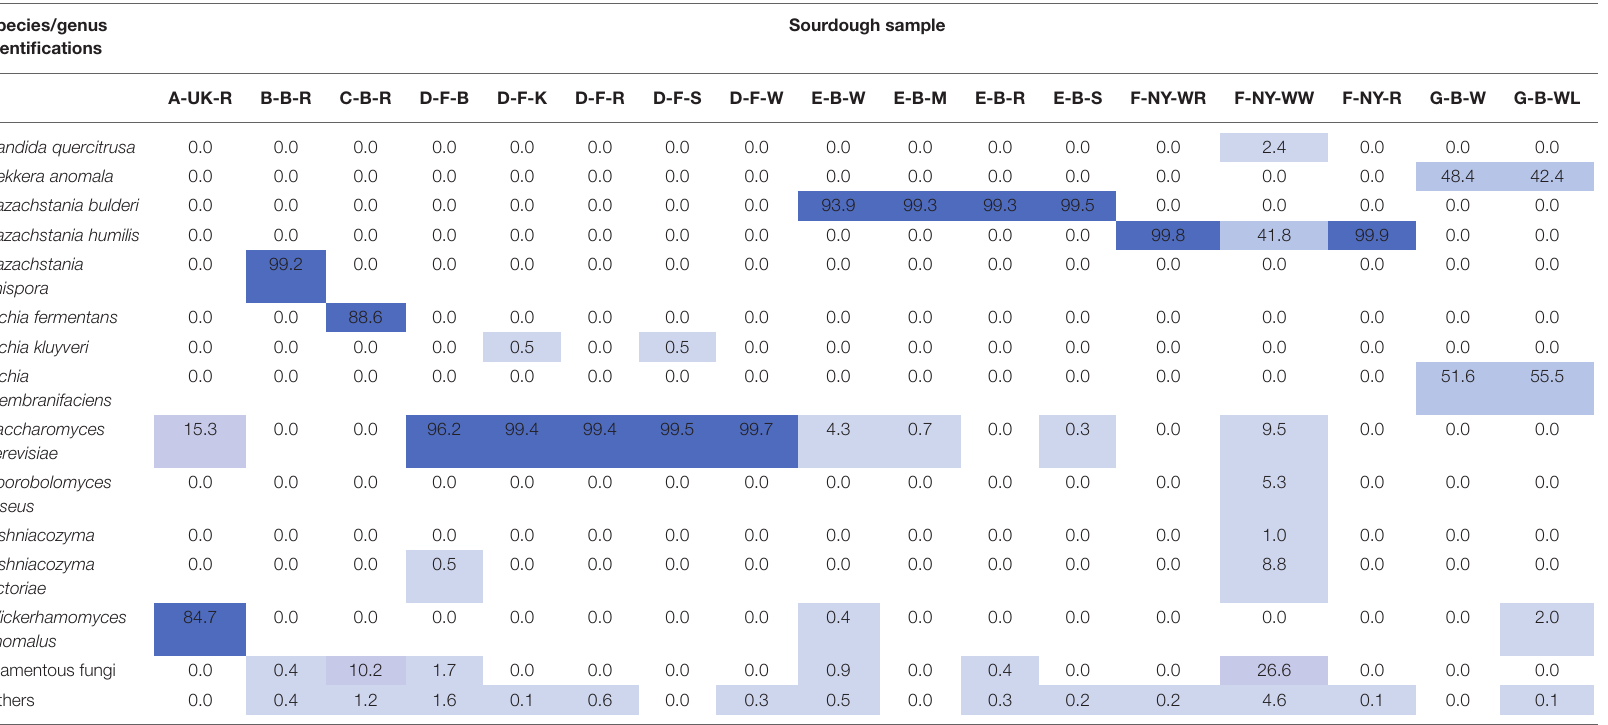
TABLE 5 | Relative abundance (%) of fungal amplicon sequence variants (ASVs) obtained through metagenetic analysis of 17 sourdough samples from backslopped sourdoughs of different origins. Species/genus